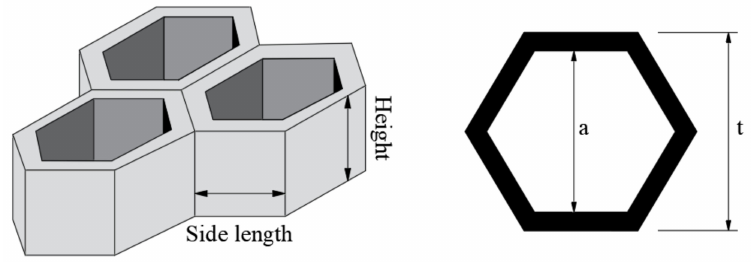
Figure 2. Honeycomb structure and unit cell (after